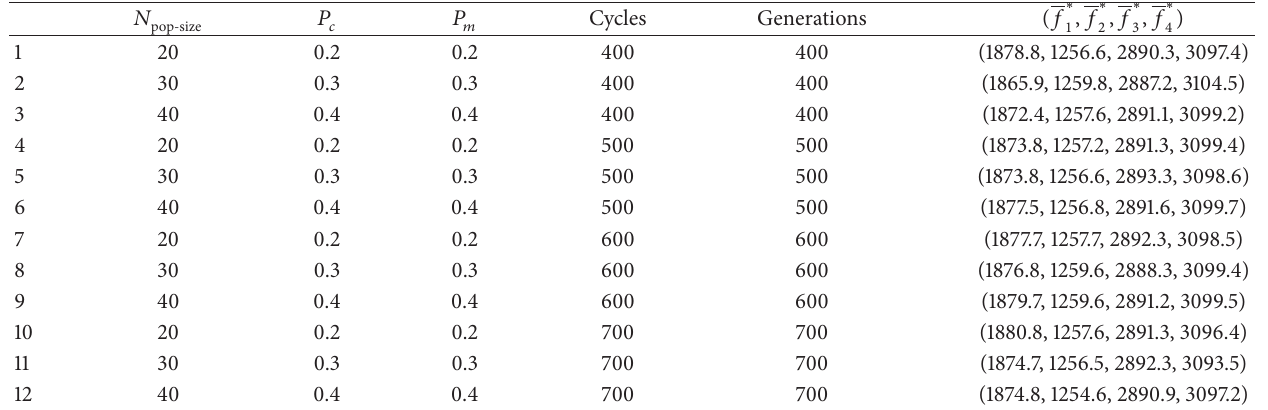
Table 4: Comparison of the results obtained with different parameters.